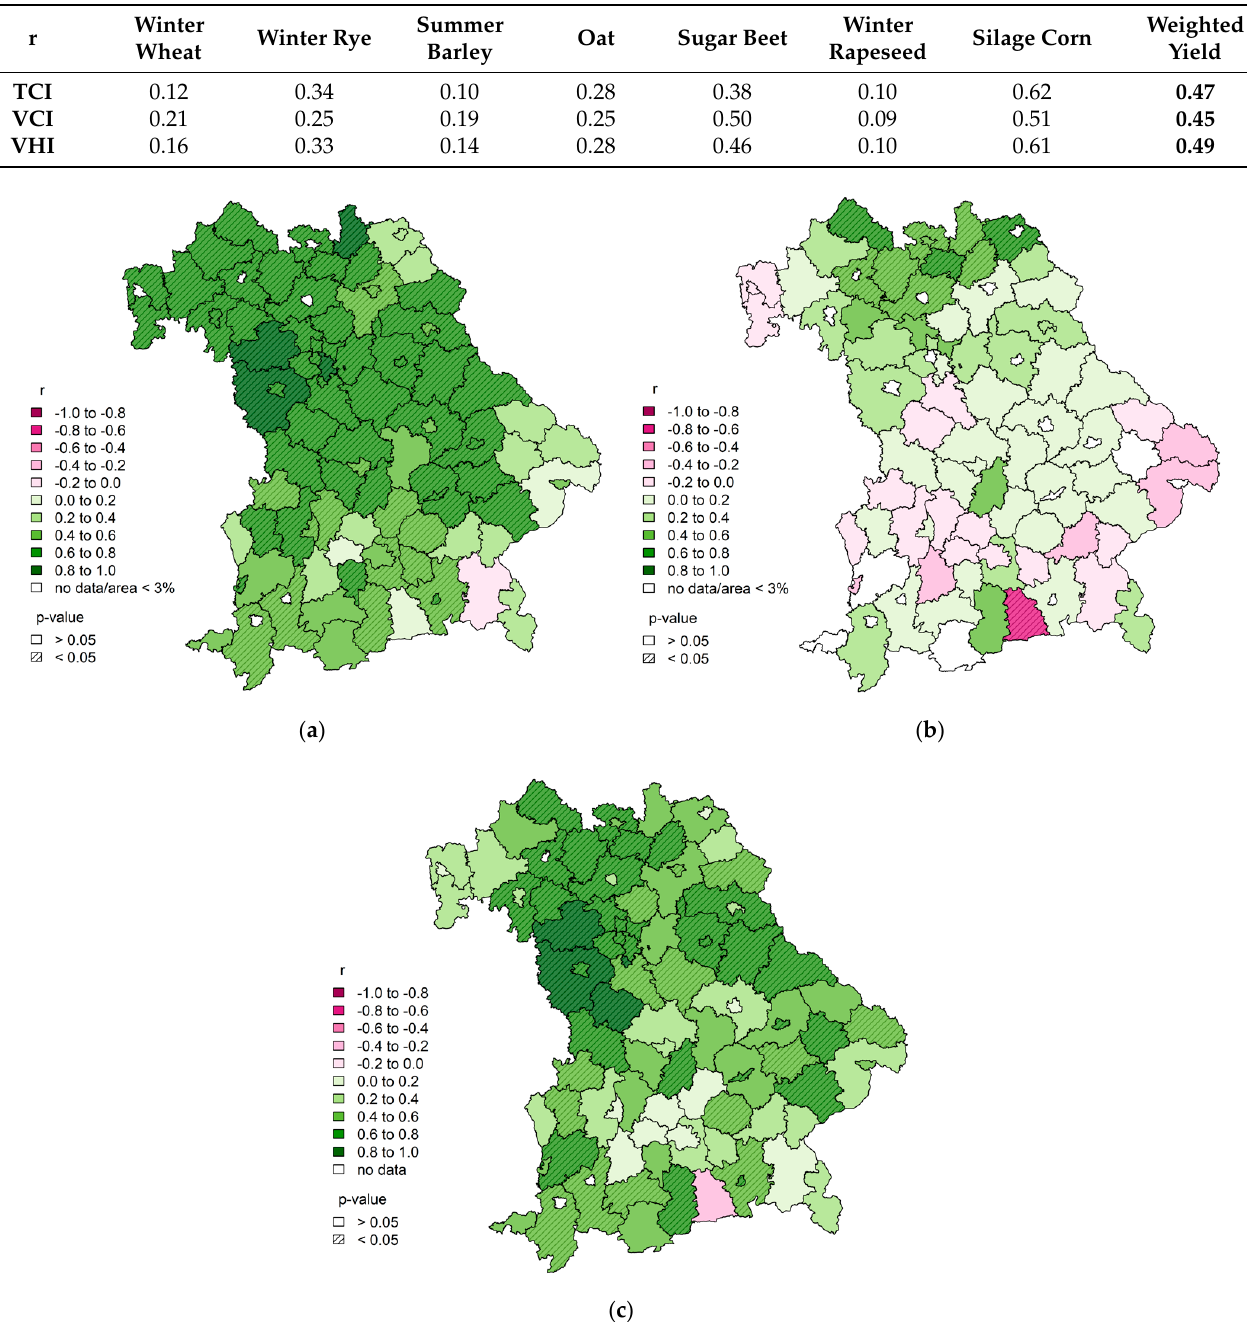
Figure 7. Bravais-Pearson correlation coefficients between ( a ) the relative annual silage corn yield anomalies and the annual mean VHI, ( b ) the relative annual winter wheat yield anomalies and the annual mean VHI, and ( c ) the annual relatively weighted crop yield anomalies and the annual weighted VHI differentiated by county. The corresponding maps with TCI and VCI are provided in Figure S9.